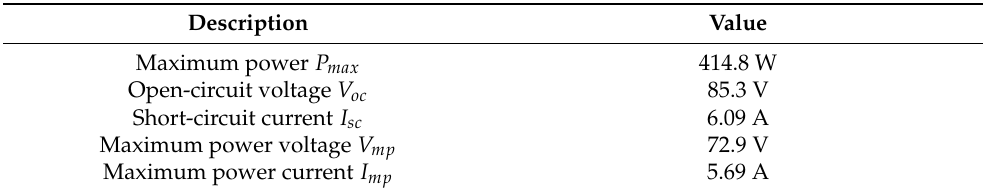
Table 3. PV module parameters.